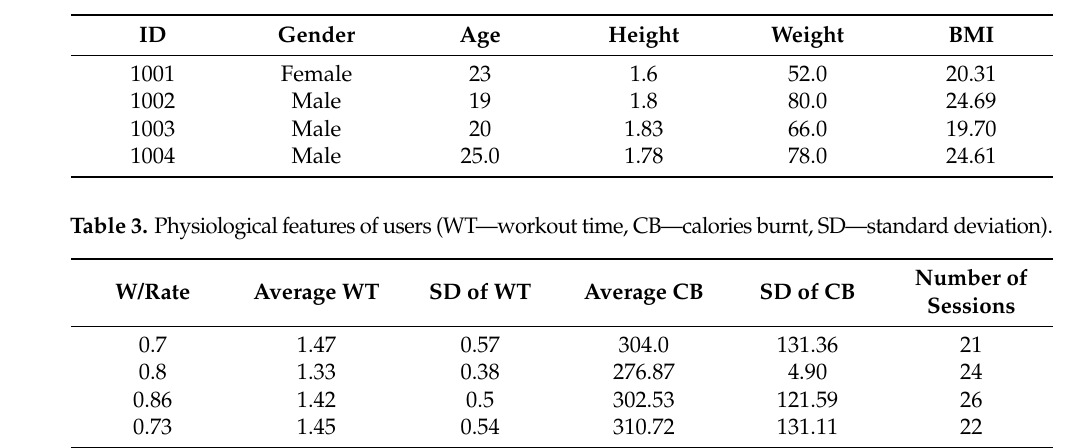
Table 2. Physical features of users.